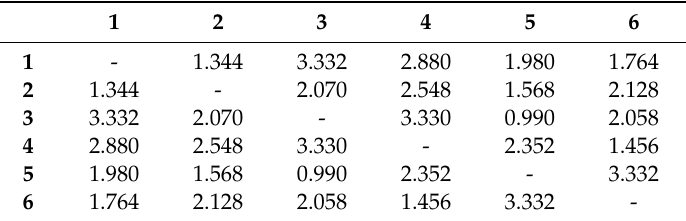
Table 4. The fuel consumption